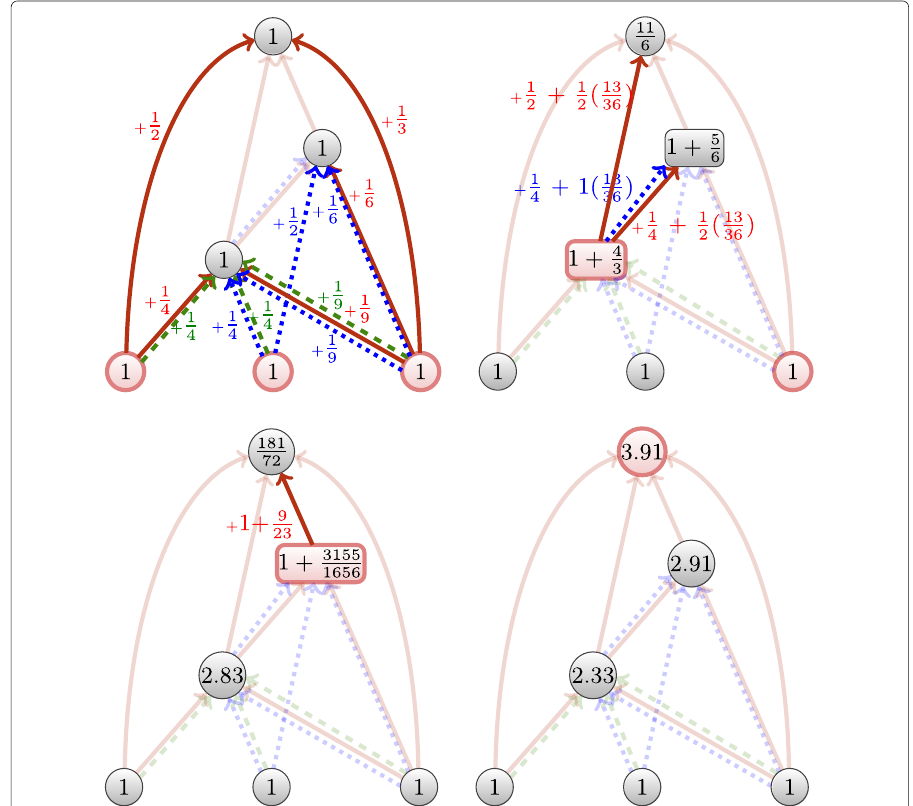
Fig. 11 The selective flow, step by step. Notice that the weight a node received on one layer is only transmitted this layer only. Only a node’s initial unit is proportionally transmitted to all other